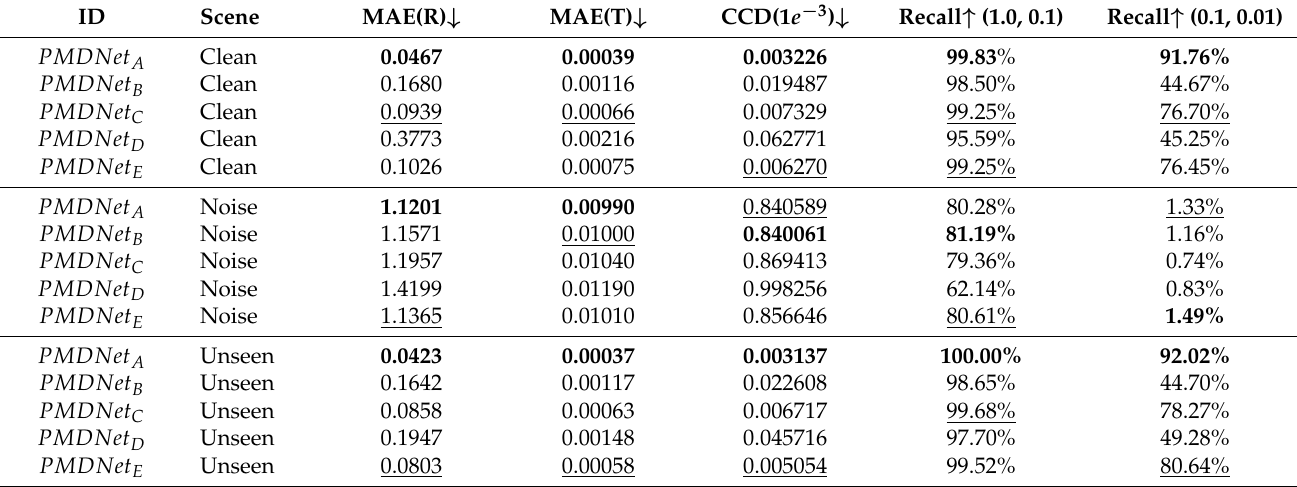
Table 3. Ablation results. PMDNet A , PMDNet B , PMDNet C , PMDNet D , PMDNet E is the same as introduced in Table 4. Bold and underline denote best and second best